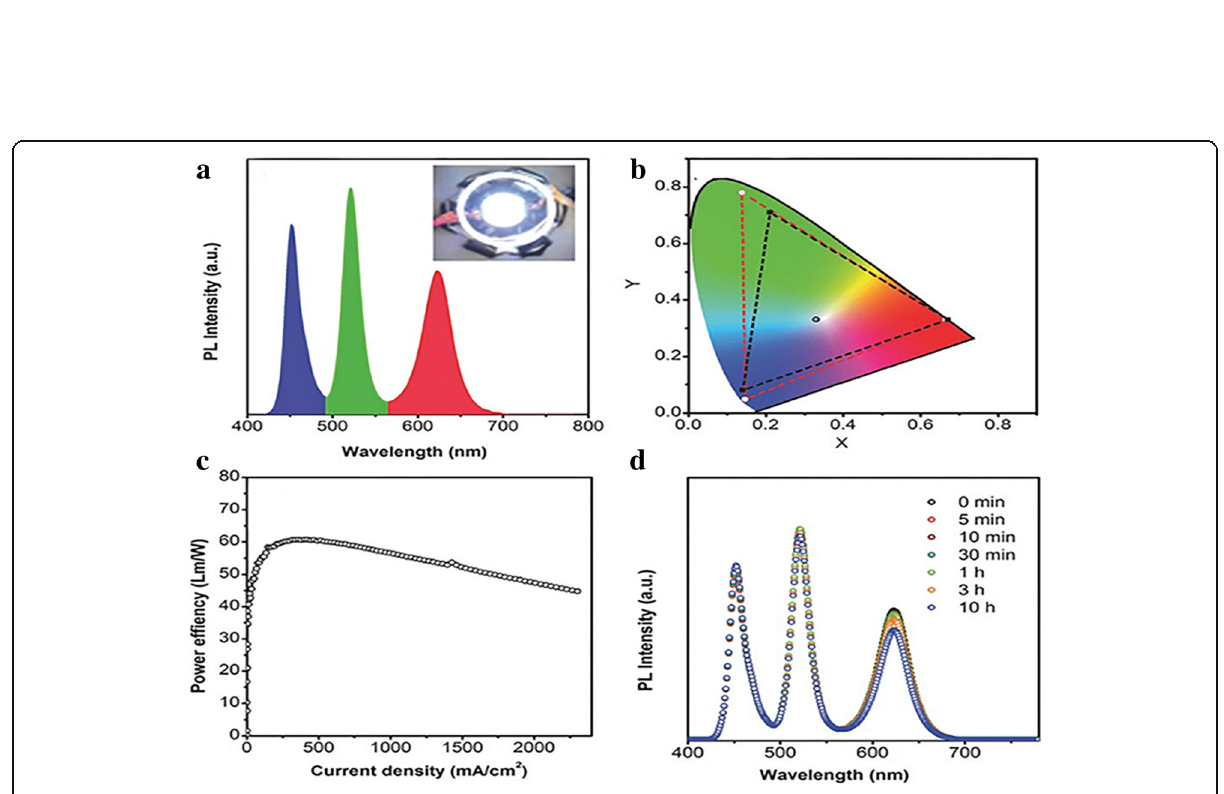
Fig. 16 The optical performances of the WLED: a the emission spectra, b the CIE color coordinates and the color triangle of WLED (red dashed line) with the NTSC TV standard (black dashed line), c the power efficiency, and d emission spectra after working for a while